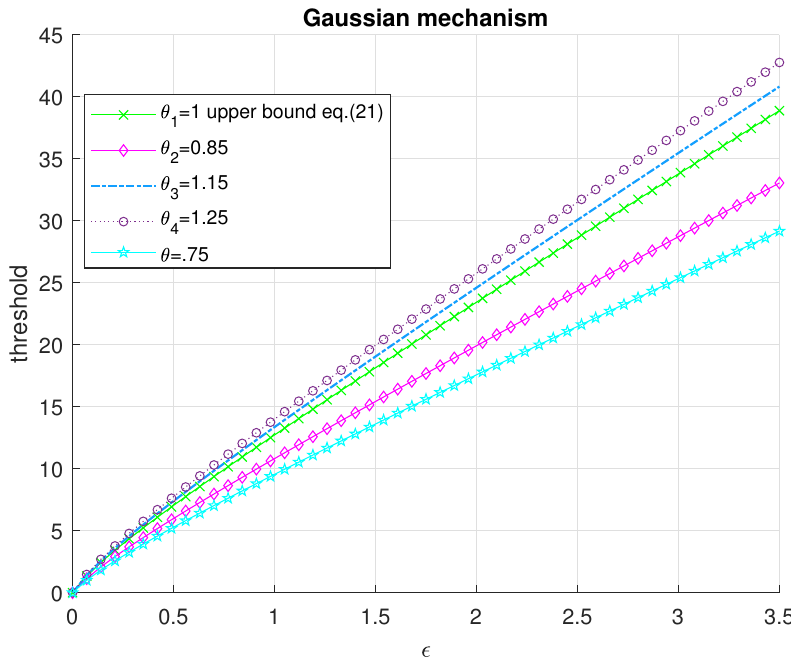
Figure 8. The upper bound (54) on the additional data’s variance vs. the chi-square table values for various values of θ .